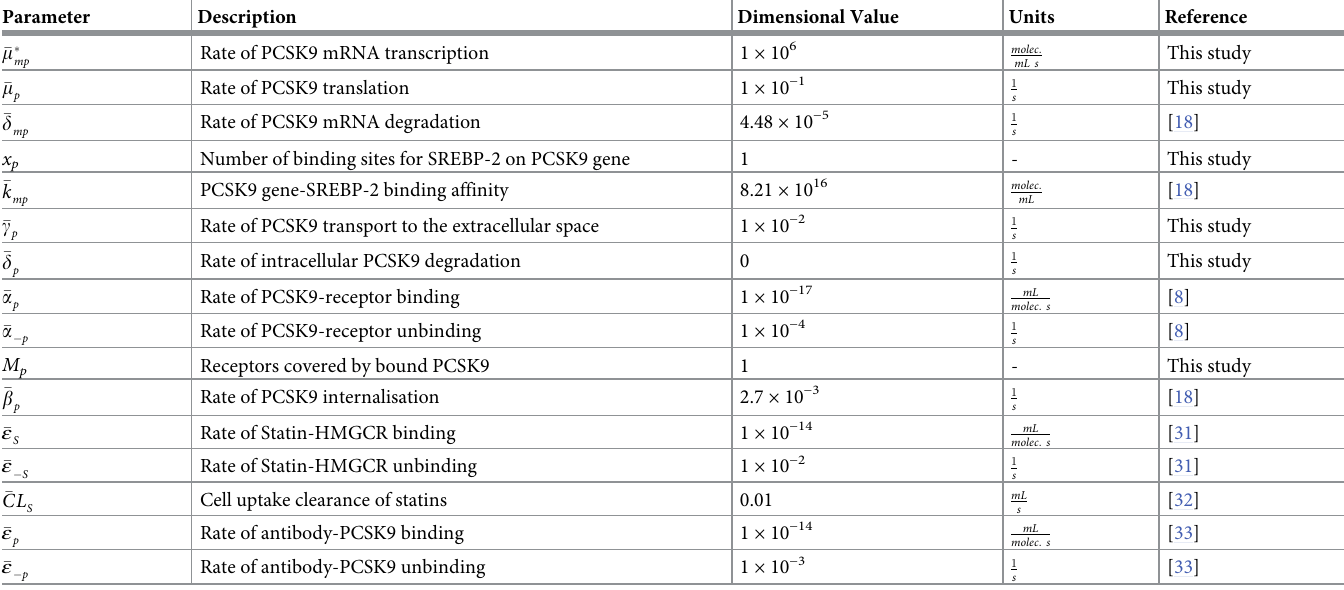
Table 1. Newly introduced model parameters. Molec. denotes